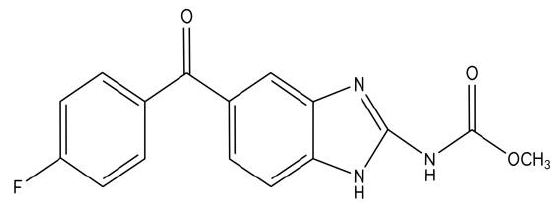
Figure 1. The structure of flubendazole.